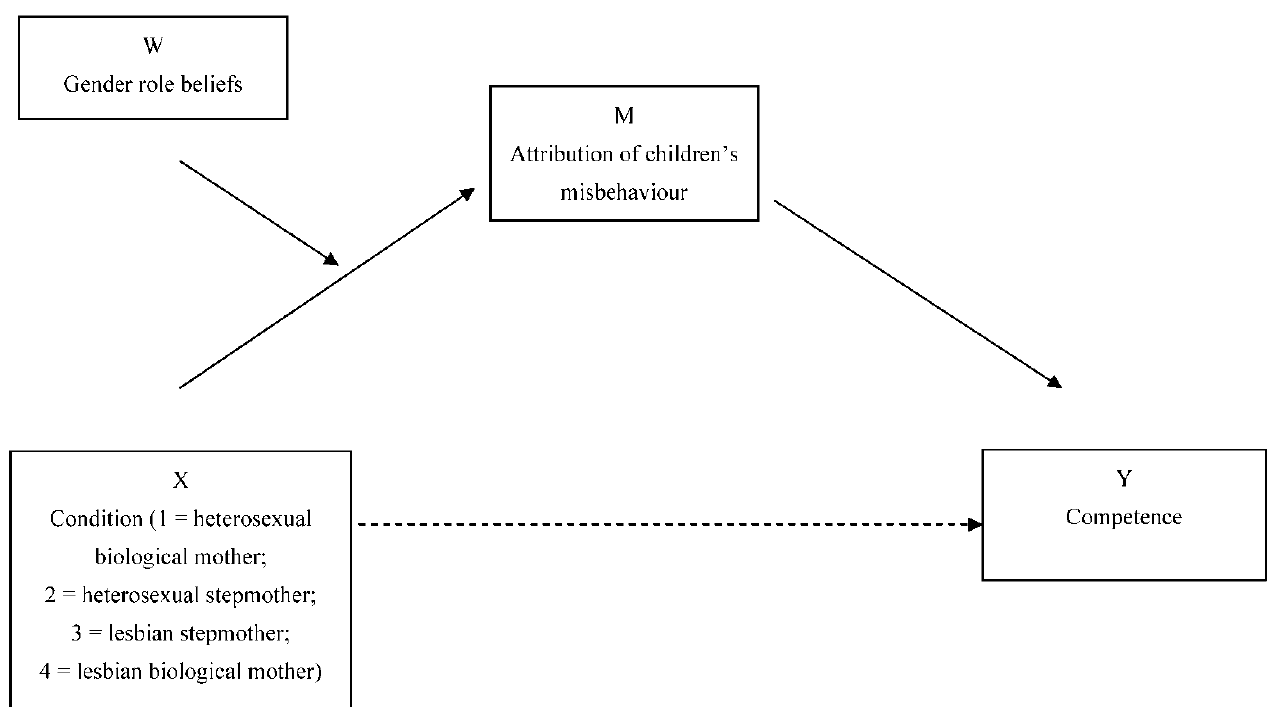
Figure 1. Conceptual Representation of the Moderated Mediation Model. Notes : X — independent variable; Y — dependent variable; M — mediator; W — moderator.